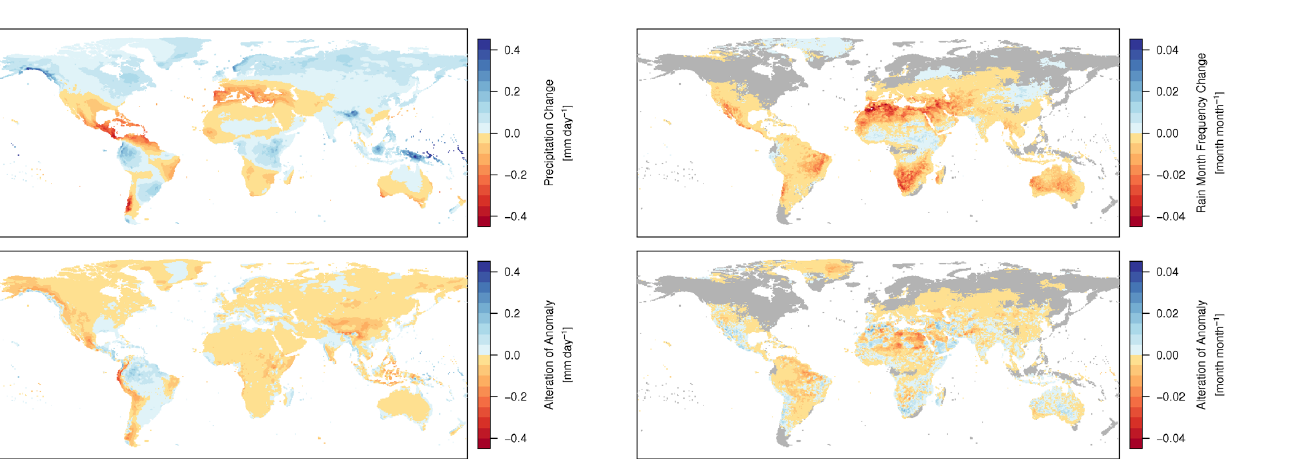
Fig. 5. Upper panel: multi-model mean of the actual applied annual mean change in precipitation rate in mm d − 1 per 1K of 1T glob (Eq. 16). Lower panel: multi-model mean of the alteration of the original anomaly in mm d − 1 for 1K of 1T glob (Eq. 17); positive values indicate an augmentation and negative values indicate an at- tenuation, regardless of the direction of change.